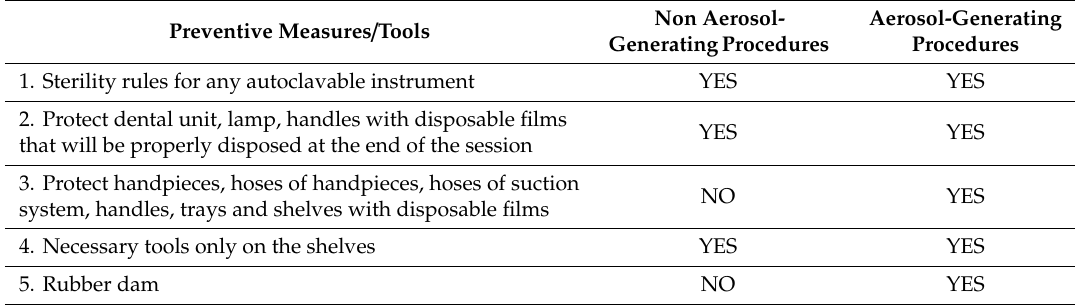
Table 4. Instruments management in aerosol / non aerosol-generating